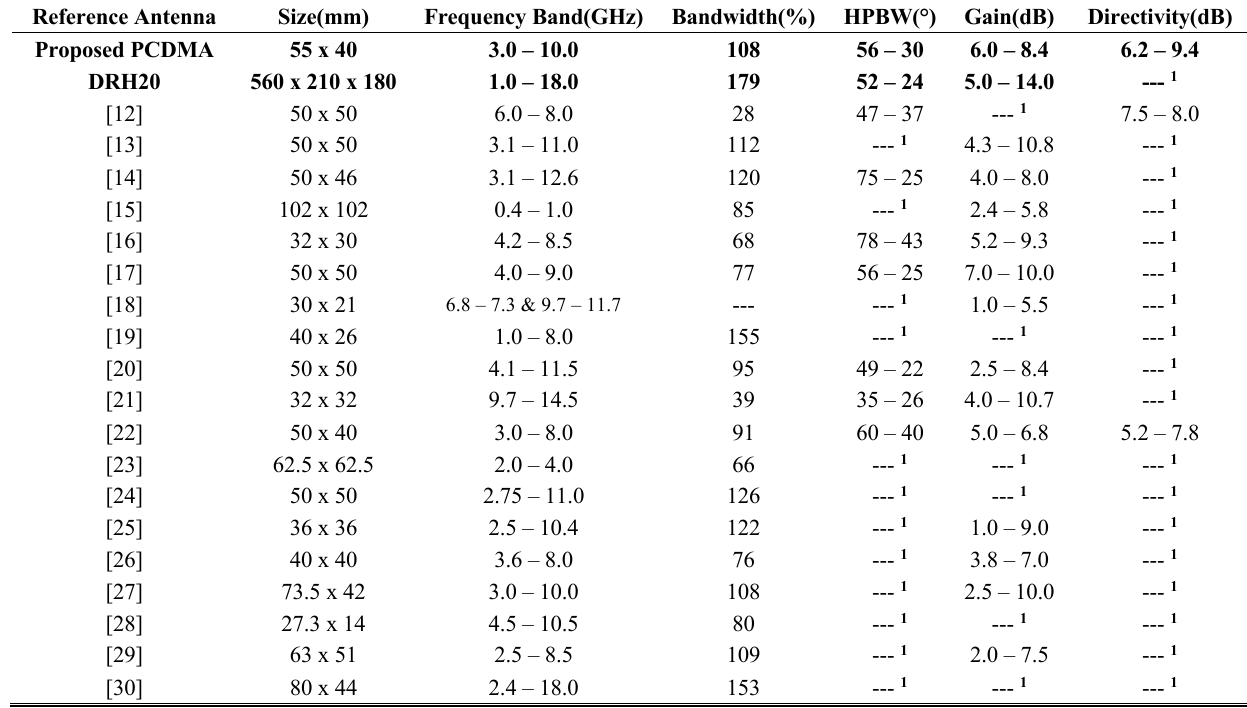
TABLE I. Comparison of the performance of the used antennas with the antennas reported in some previous work Reference